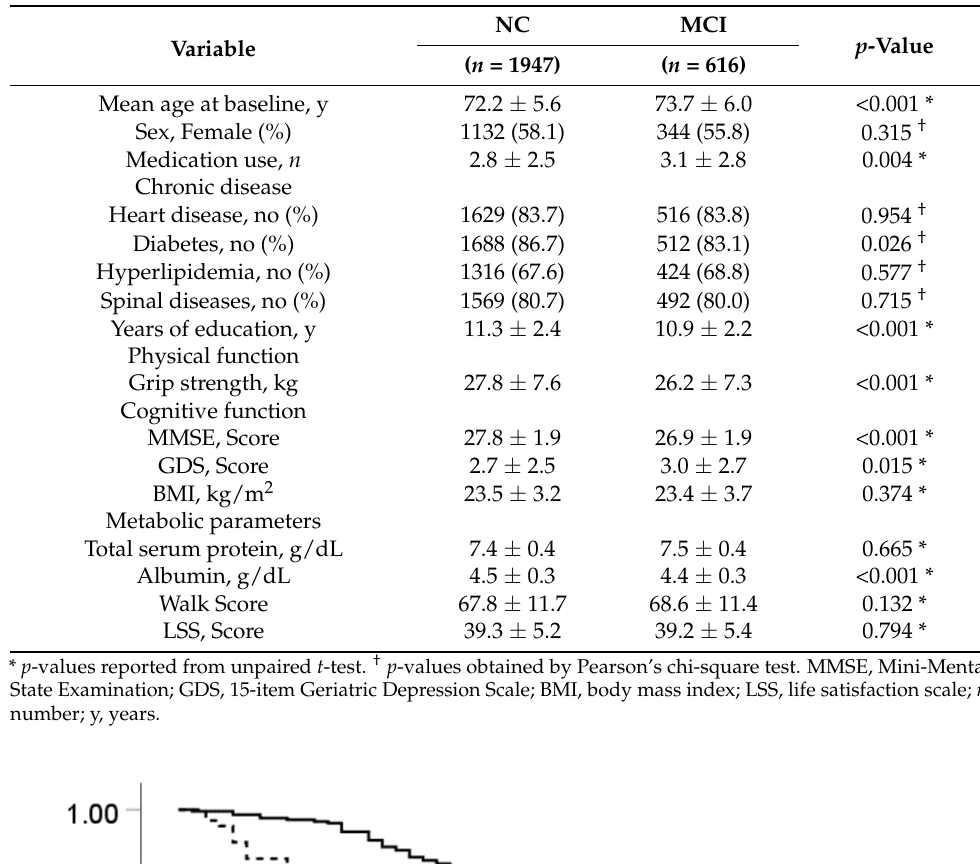
Table 2. Baseline characteristics of study participants by cognitive status.